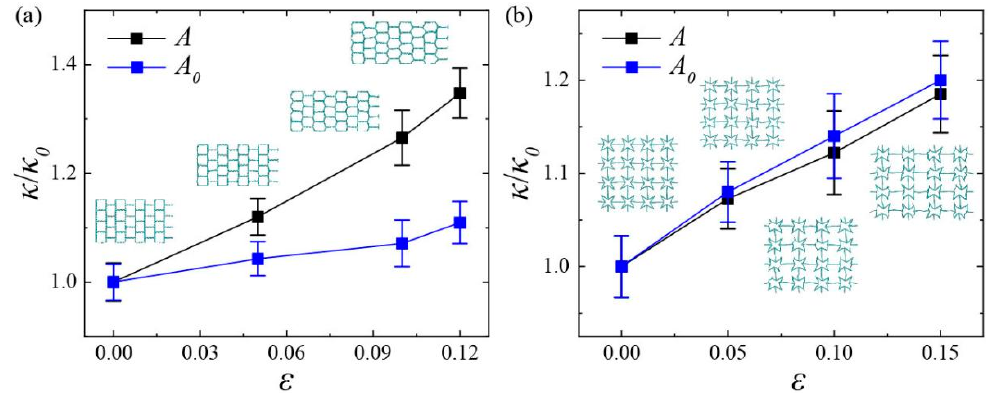
Figure 9. Relative thermal conductivity of ( a ) SKG and ( b ) QSS models in the x direction as a function of uniaxial tensile strain. A ( A 0 ) represents actual (initial) cross-section area with (without) considering the variation of lateral area.